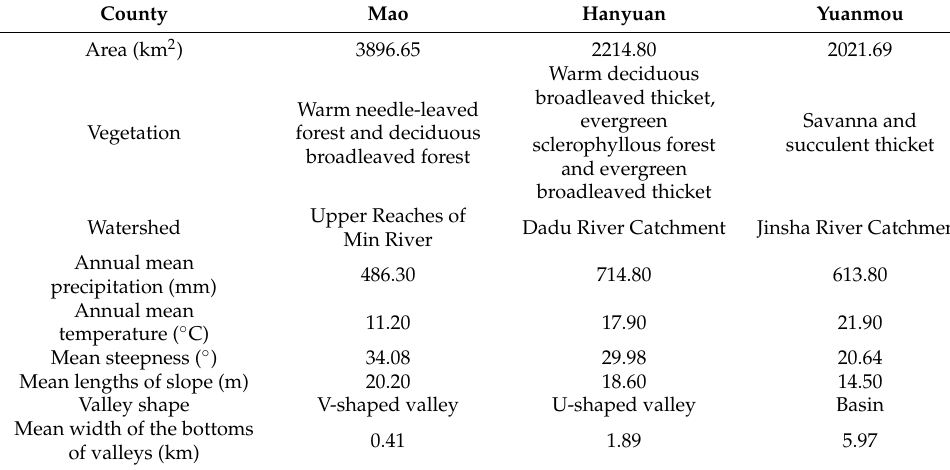
Table 1. Geographical information for the three counties.